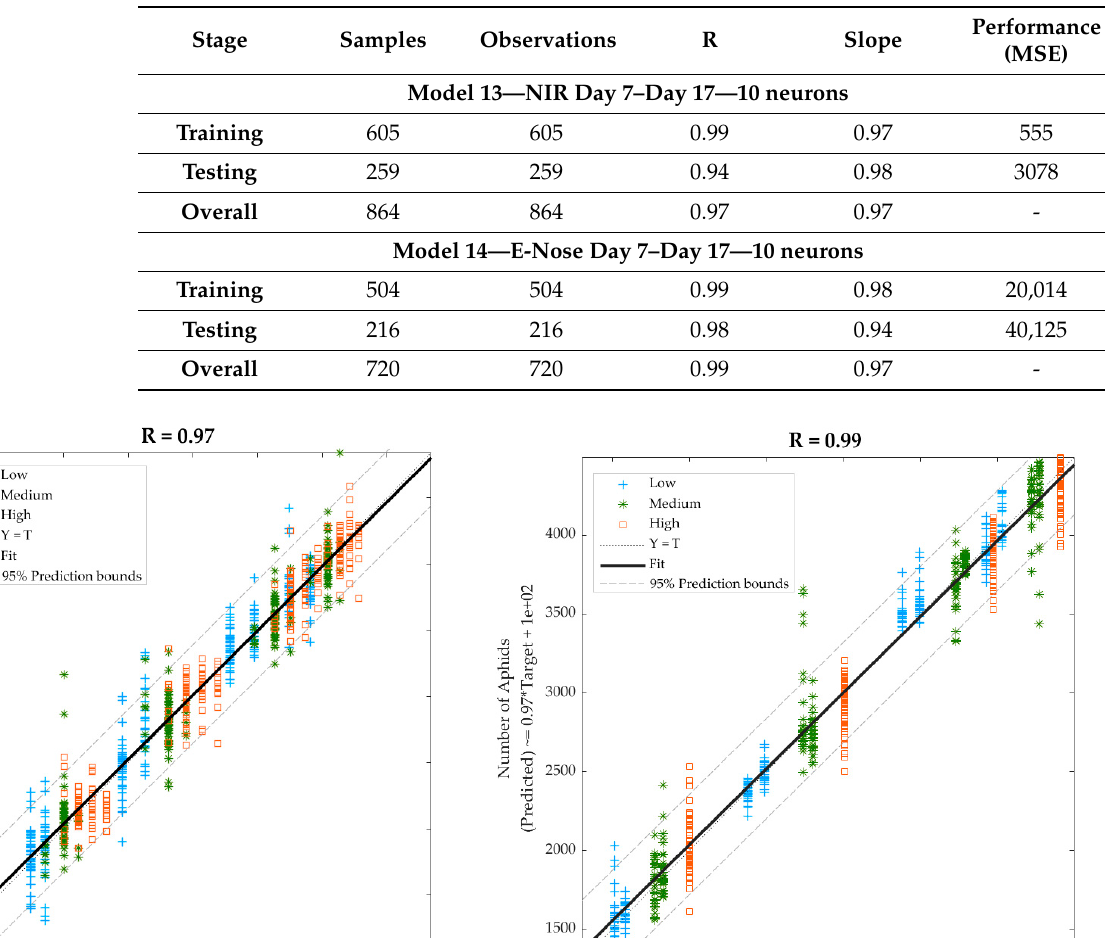
Table 5. Machine learning regression models based on artificial neural networks (Bayesian Regular- ization) to predict the number of aphids’ data using the near-infrared absorbance values (Model 13) and electronic nose outputs (Model 14) from Days 7 to 17 as inputs. Abbreviations: R: correlation